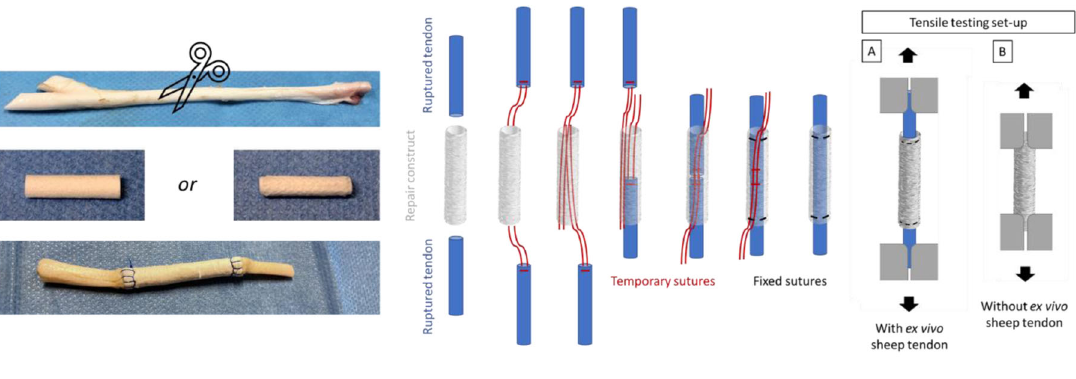
Fig. 1 Set-up of the tensile testing set-up of the repair construct on the ex vivo sheep tendon. Tensile testing set-up: A with ex vivo sheep tendon, clamping the tendon ends in the tensile machine, B without ex vivo sheep tendon, clamping the repair constructs ’ end in the tensile